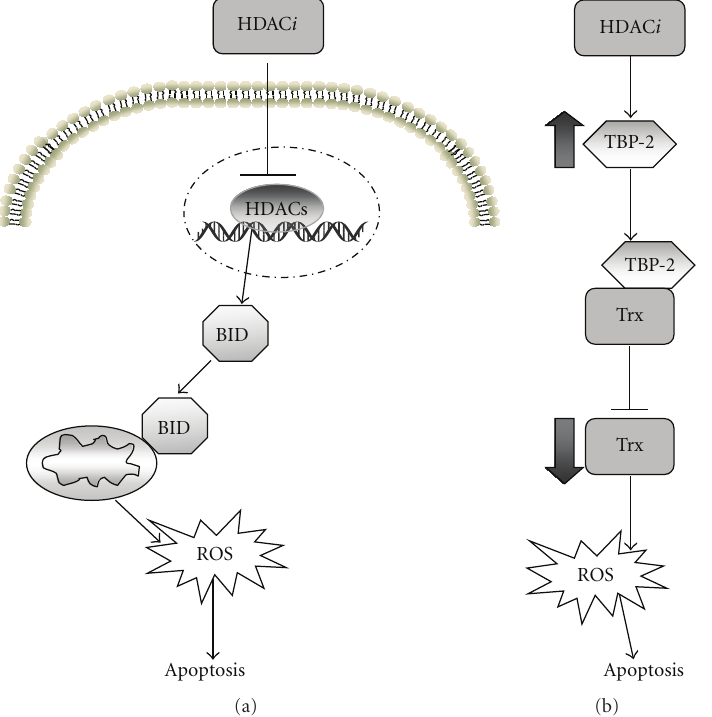
Figure 1: Proposed mechanisms by which HDACi induce ROS. (a) Mitochondrial injury. HDACi induces expression of Bid protein. This proapoptotic molecule binds to and disrupts the mitochondrial membrane, which results in increased ROS levels and apoptosis. (b) Alterations in antioxidant levels. HDACi upregulate the expression of thioredoxin-binding protein-2 (TBP-2). TBP-2 binds to and inhibits the antioxidant thioredoxin (Trx). This inhibition results in an imbalance of oxidants and antioxidants leading to increased ROS levels, which promotes